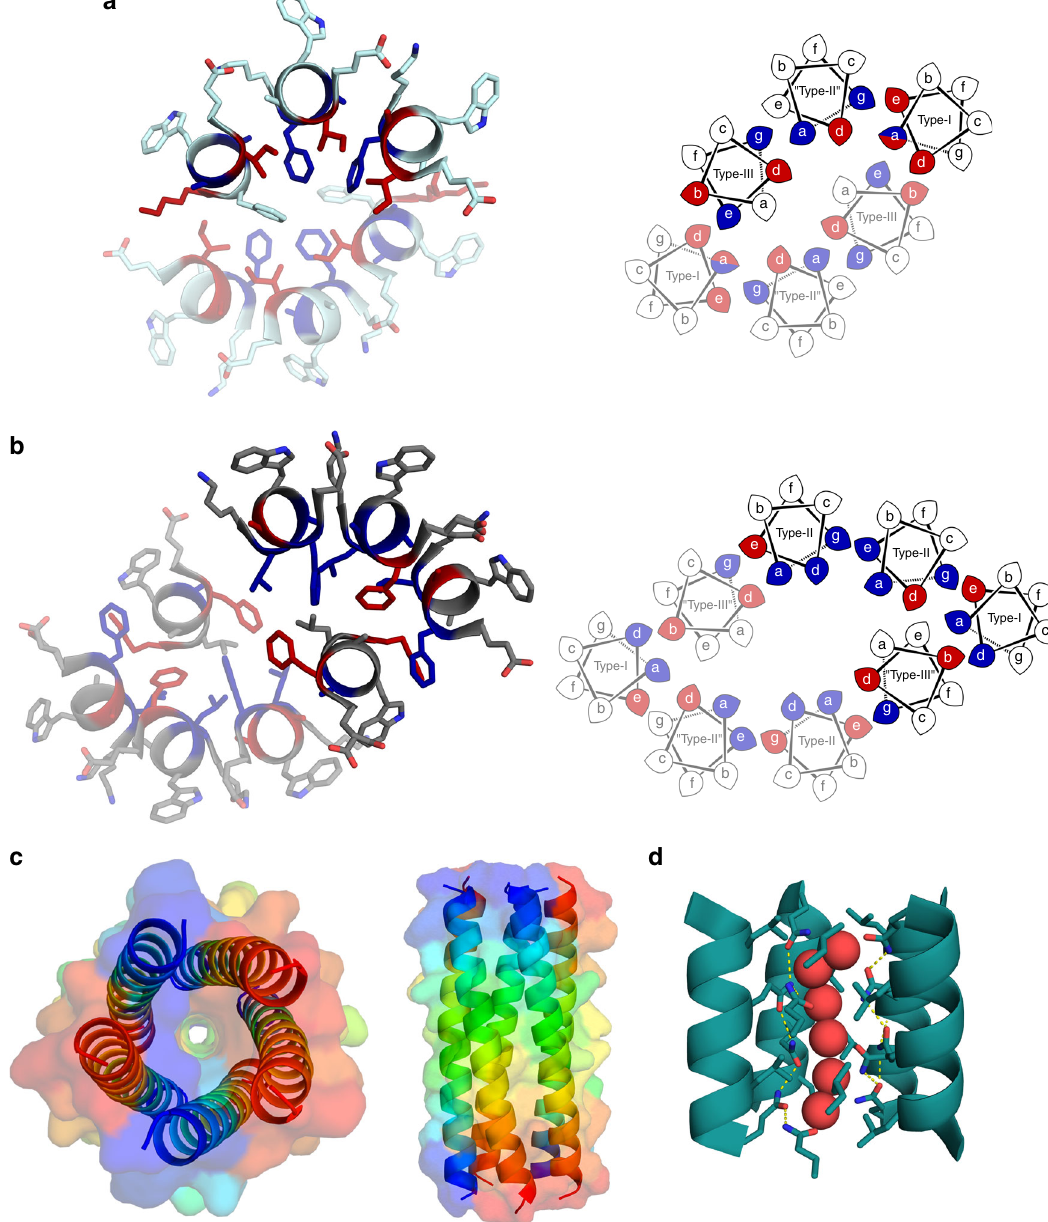
Fig. 6 Coiled-coil bundles containing aromatic cores and 5H2L_2.1-I9L. a CC-Type2-FI and b CC-Type2-LF. Left-hand side, single-heptad slices through X-ray crystal structures. Right-hand side, helical-wheel representation with knob residues coloured red for parallel-like packing and blue for perpendicular- like packing. Semi-transparent helices are symmetry related to the opaque helices. c Mixed parallel/antiparallel structure of the point mutant 5H2L_2.1-I9L 25 . d Cross-section through the 5H2L_2.1-I9L structure revealing a buried hydrogen-bond network (yellow dashes) with bound water